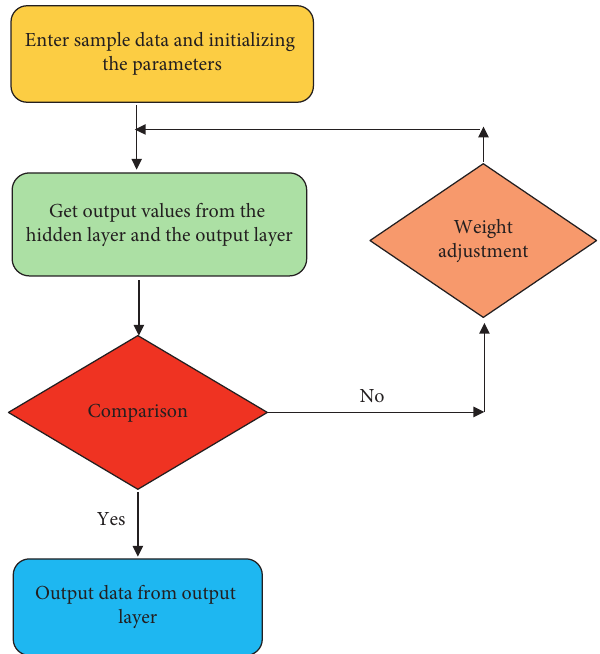
Figure 2: Back propagation flow chart of the BP neural